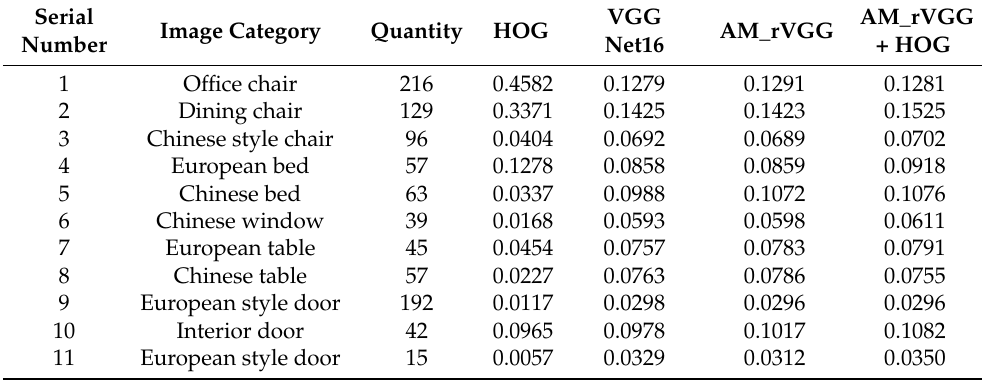
Table 4. mAP values for the different types of furniture.